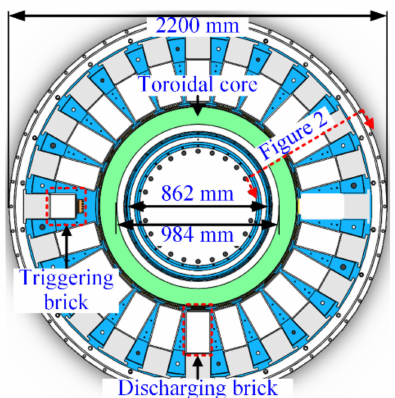
Figure 1. Top-down illustration of the newly developed 1-mega-ampere (MA) single-stage fast linear transformer driver (FLTD) cavity with top lid and insulator